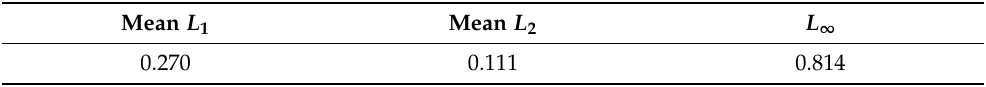
Table 1. Error calculating over the complete area of the